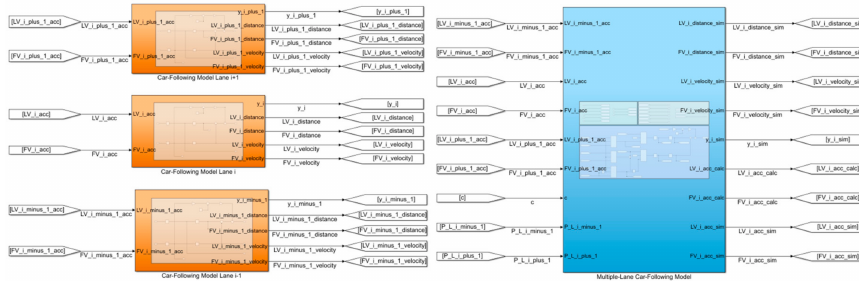
Figure 6. Main subsystems overview—implementation using Simulink (MATLAB R2020a).